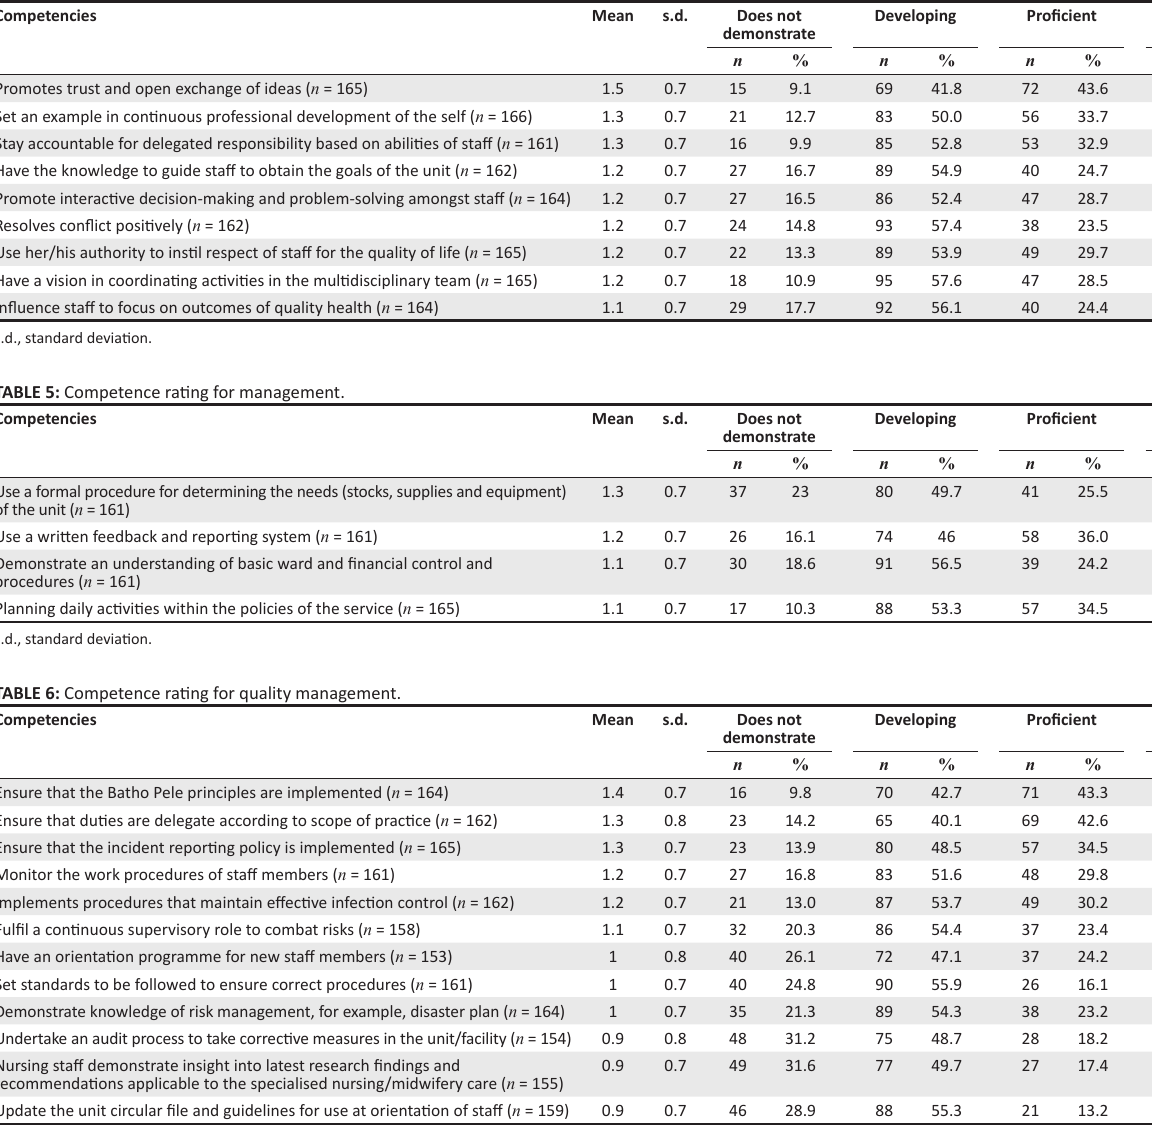
TABLE 4: Competence rating for leadership.